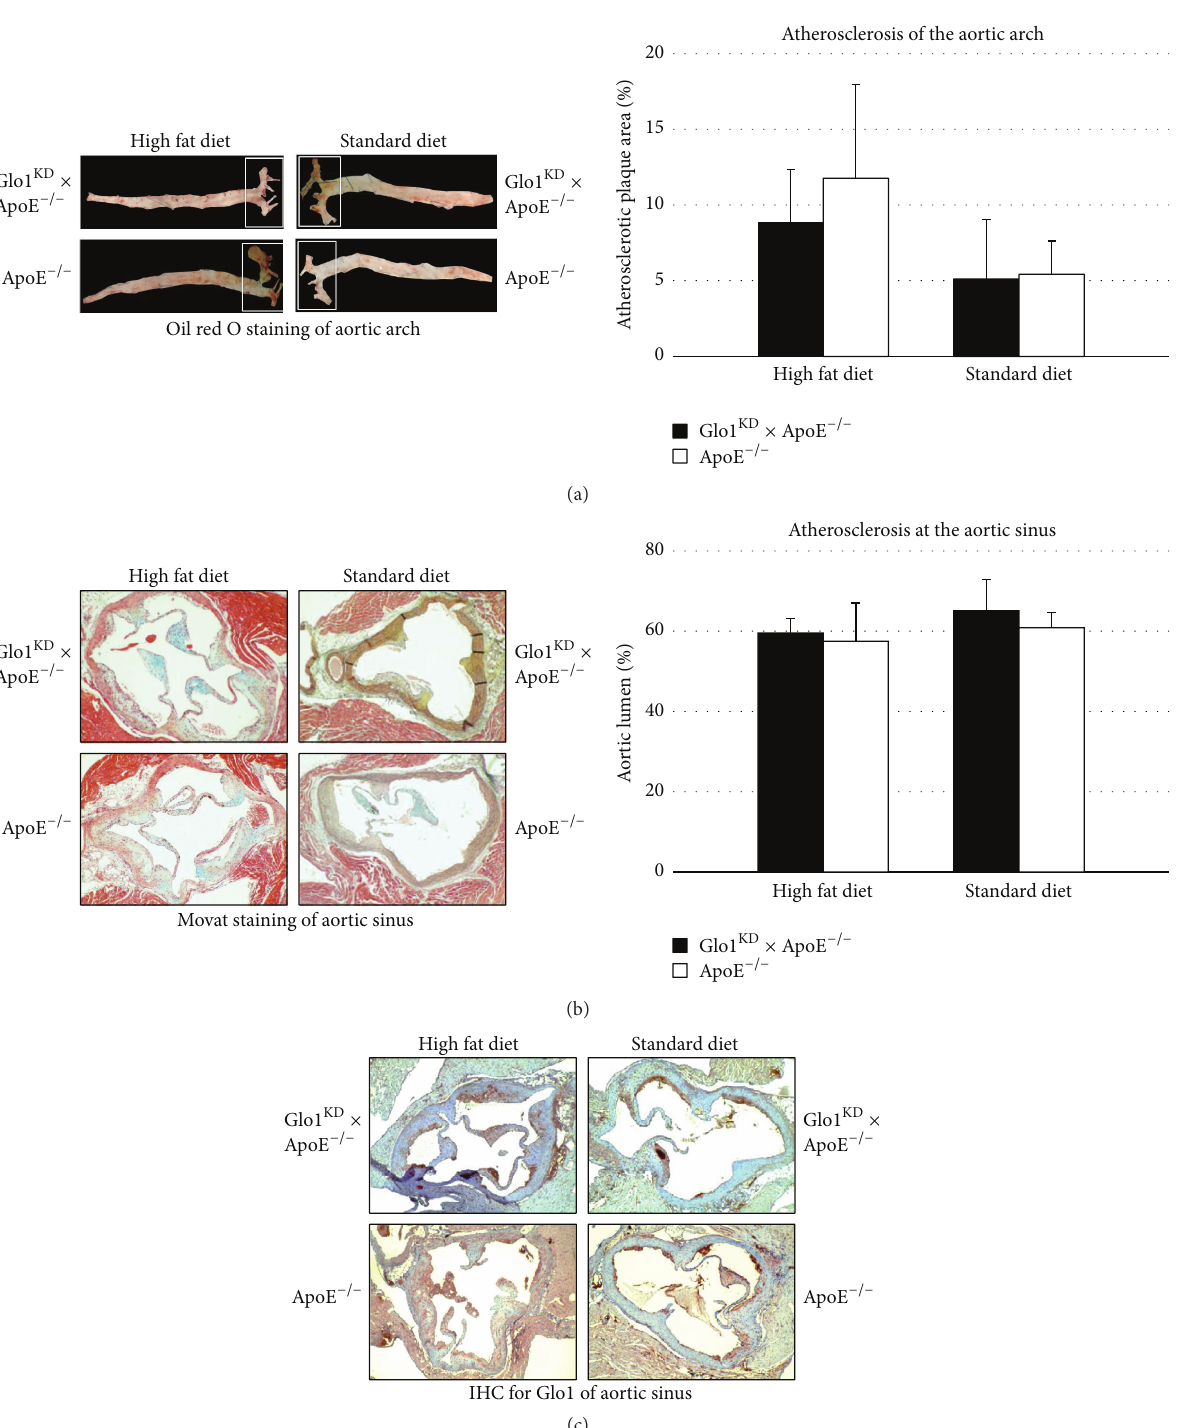
Figure 4: (a) En face preparations were performed in order to quantify the amount of atherosclerotic plaques. Bars refer to the mean of oil red O positive areas, analyzed in relation to the total area of the aortic arch ± standard deviation. The knockdown of Glo1 did not show any significant effect on the formation of atherosclerotic plaques ( 𝑝 ≥ 0.05 ). (b) Transversal sections of the aortic sinus were stained via a MOVAT staining in order to analyze the atherosclerotic plaque formation. Bars represent the mean of the aortic lumina (as determined by ImageJ analysis, lumen area in relation to the total area surrounded by the outer media). The Glo1 knockdown did not have a significant impact of the stenosis caused by atherosclerotic plaques ( 𝑝 ≥ 0.05 ). (c) Immunohistochemical detection of Glo1 performed with transversal sections of the aortic sinus. Glo1 was mainly detected in the atherosclerotic